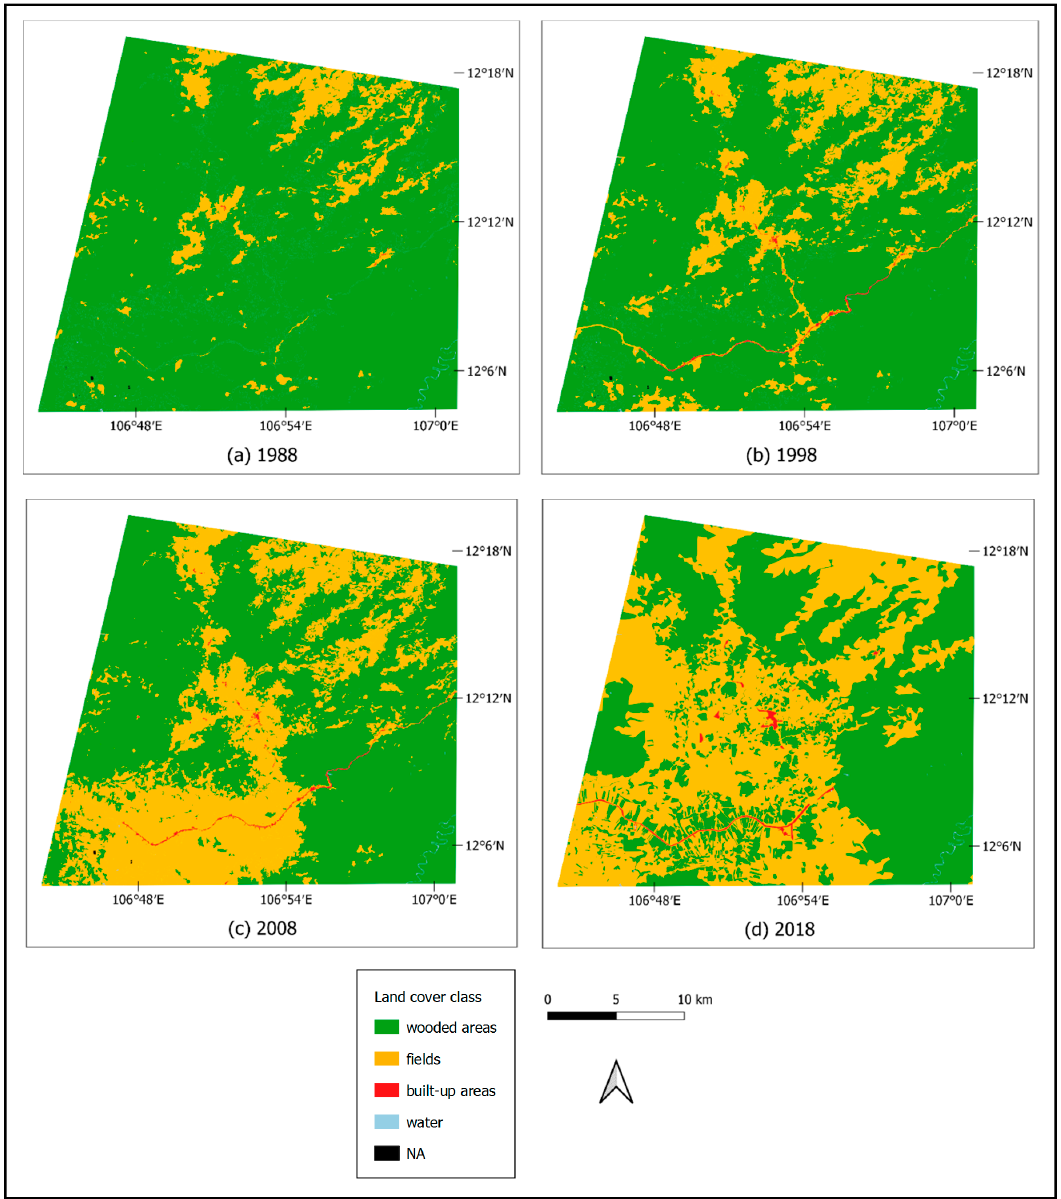
Figure 7. Evolution of land cover between 1988 and 2018 with ( a ) Land cover in 1988; ( b ) Land cover in 1998; ( c ) Land cover in 2008; ( d ) Land cover in 2018 (NA: not attributed). Deforestation keeps expanding (Figure 8); from 1988 to 2018, the extent of wooded areas decreased from 90.78% to 47.41% while the percentage of landscape classified as fields increased from 9.11% to 51.98%. Built-up areas also increased from 0.018% in 1988 to 0.531% in 2018, extending the existing patches as a consequence of urbanization and the development of villages and roads.